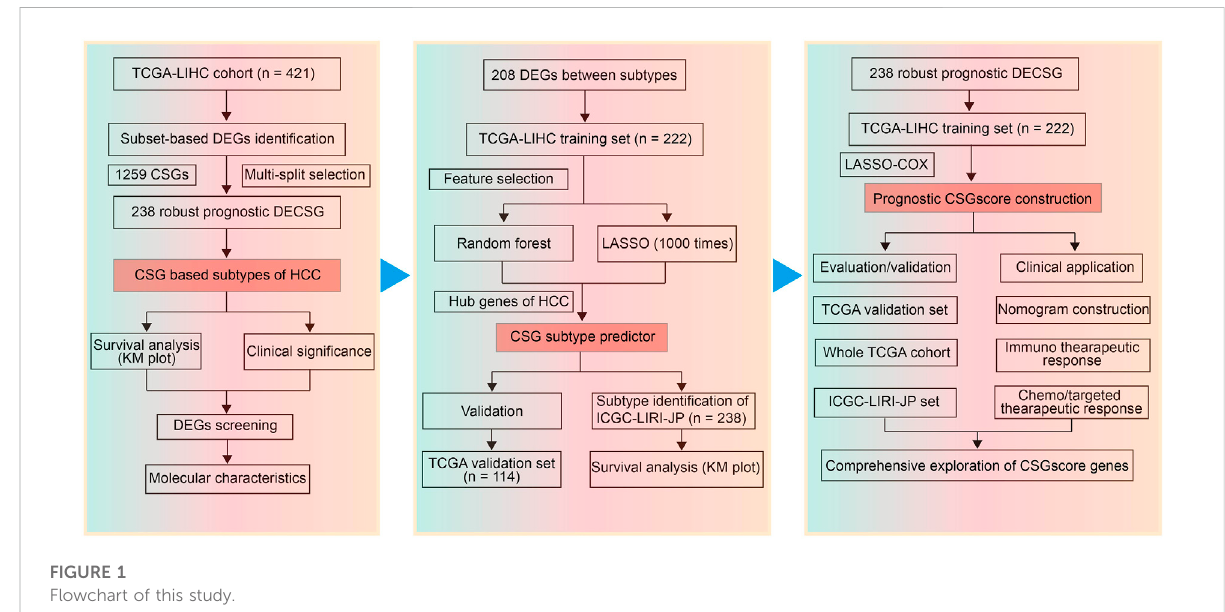
FIGURE 1 Flowchart of this